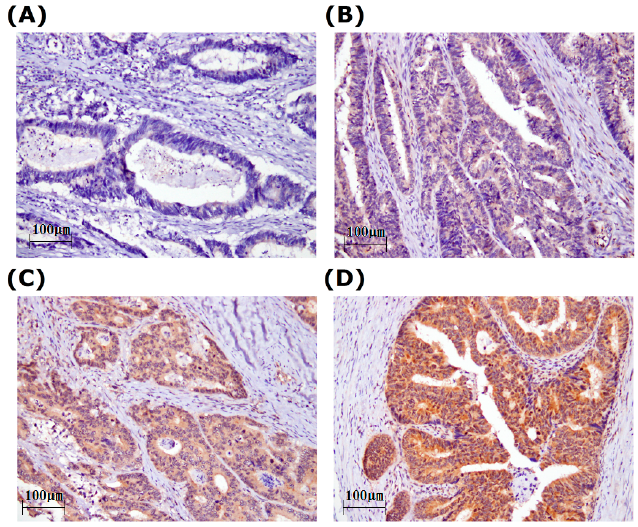
Figure 1. Representative immunostaining of STEAP1 in colorectal cancer in tissue arrays. STEAP1 expression scores were ( A ) 0; ( B ) 100; ( C ) 200; ( D ) 300. Table 1. Relationships of STEAP1 expression with clinical parameters in colorectal cancer patients.